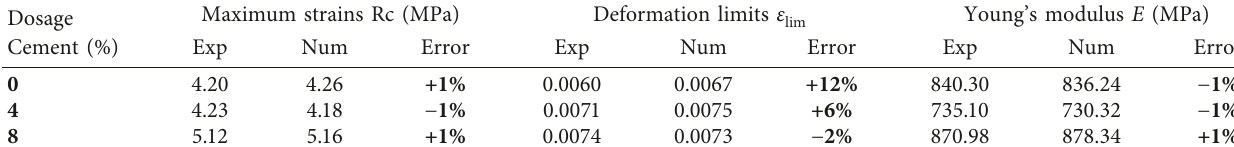
Table 2: Mechanical characteristics of MAI’s CEBs and CSEBs.